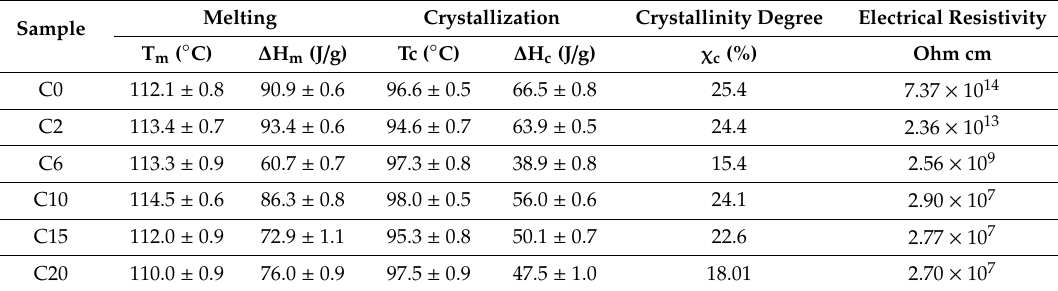
Table 4. Crystallization, melting temperatures and enthalpies, and degree of crystallinity, and electrical resistivity of LDPE / HIPS blend and LDPE / HIPS / TWP composites. The standard deviation is based on at least three